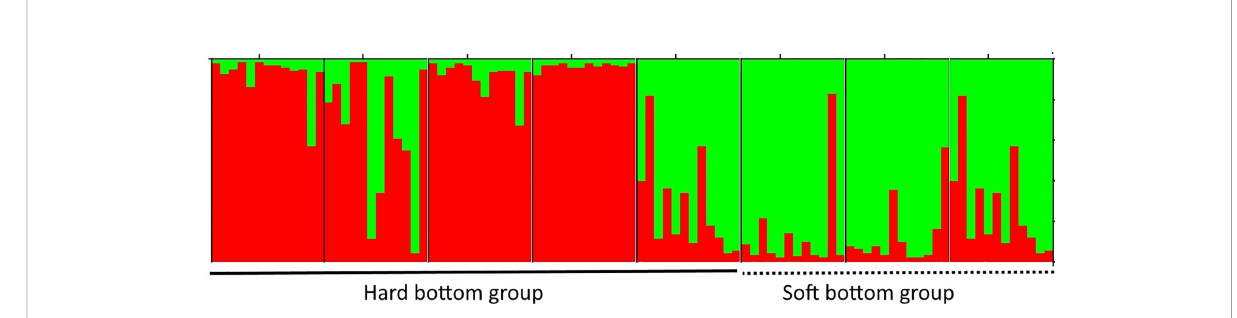
FIGURE 4 The cluster analysis of the Thalassia hemprichii population from southern Viet Nam based on nine microsatellite loci. Eight populations were divided into two groups consisting of the open sea and lagoon clusters. Adapted from Nguyen et al.